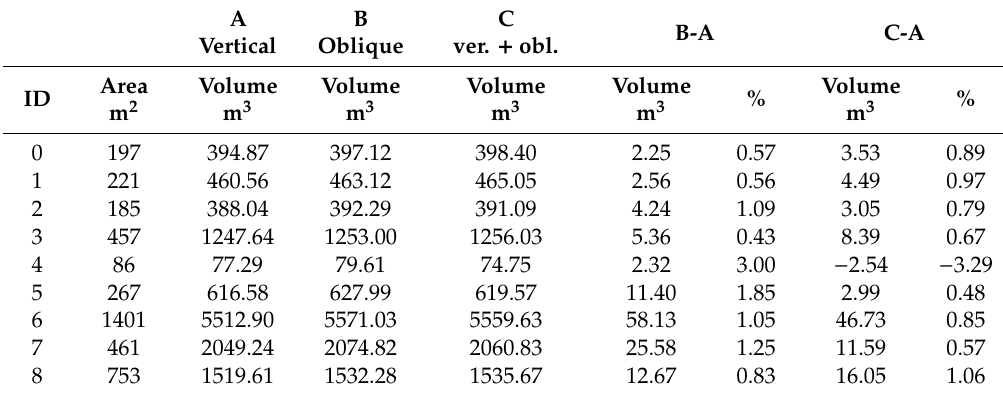
Table 6. Comparison among the volumes computed in the three scenarios.